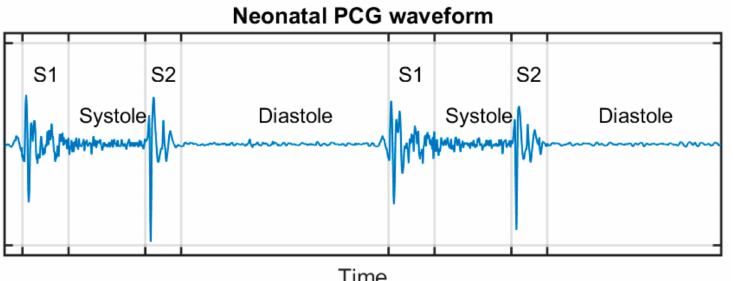
Figure 4. Two consecutive cardiac cycles showing a phonocardiogram waveform along with its four sound phases: S1, systole, S2, and